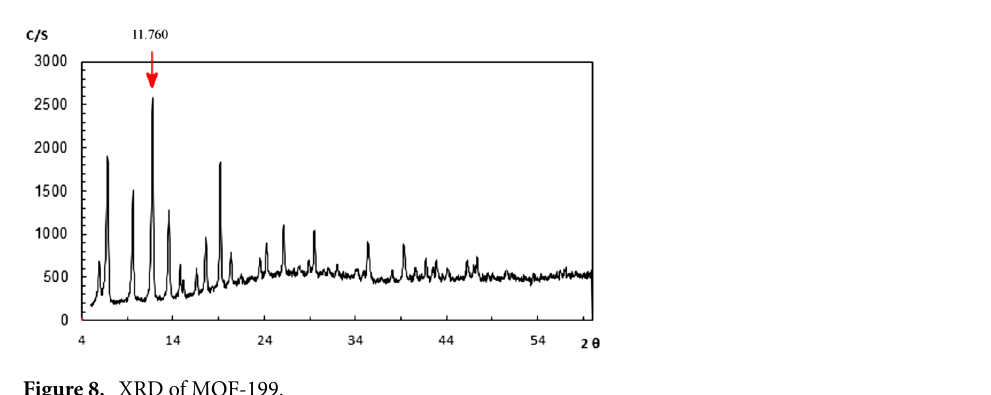
Figure 8. XRD of